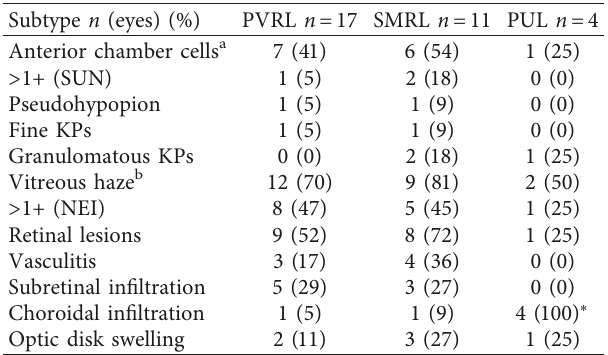
Table 3: Ocular signs in primary and systemic metastatic lym- phomas at